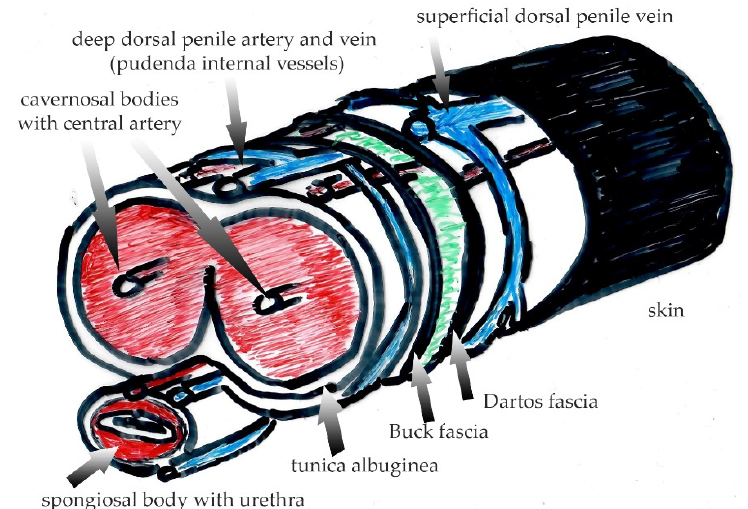
Figure 2. Penile anatomy with different layers separated by the Dartos’ and Buck’ fasciae. Note that innervation and blood supply to the outer skin is provided by the genitofemoral nerve and external pudendal vessels whereas the glans and the inner sheath of the foreskin are supplied by the dorsal penile nerve (originating from the pudendal nerve) and by the dorsal penile vessels (originating form the internal pudendal arteries and veins). Green color depicts the space between Dartos and Buck fascia with loose connective tissue intertwined between both fasciae, which enables unimpaired skin movement during erectile volume shifts.